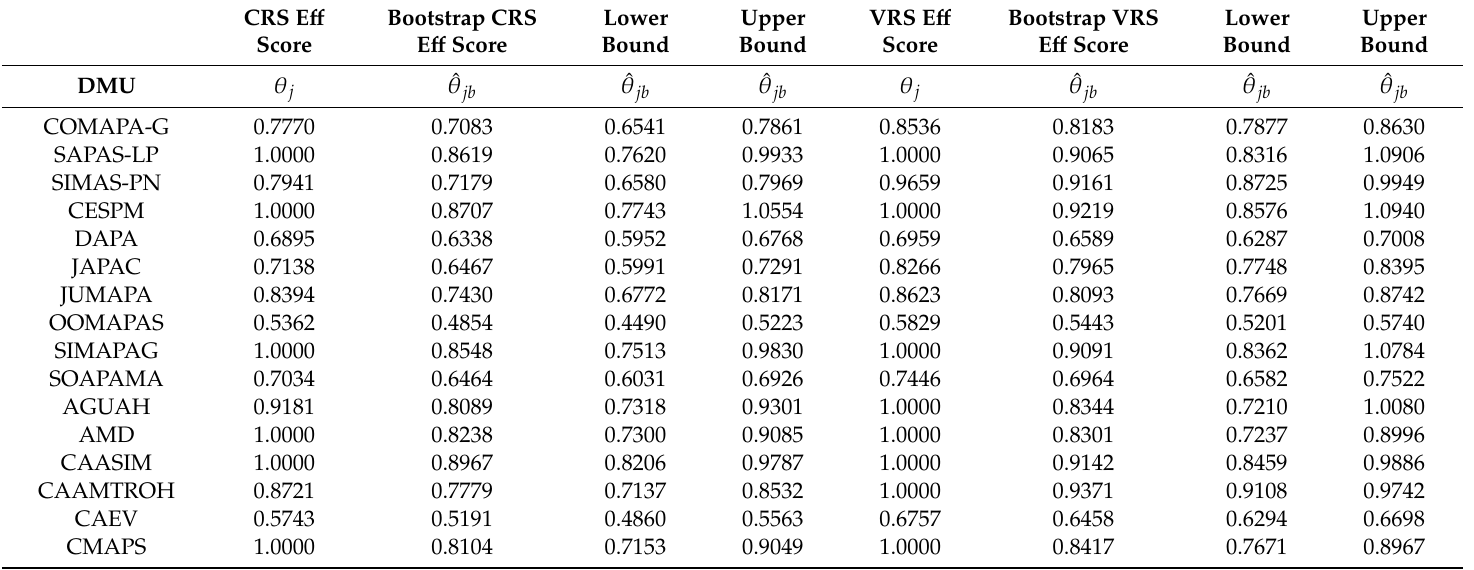
Table 10. Bootstrap e ffi ciency scores and their confidence